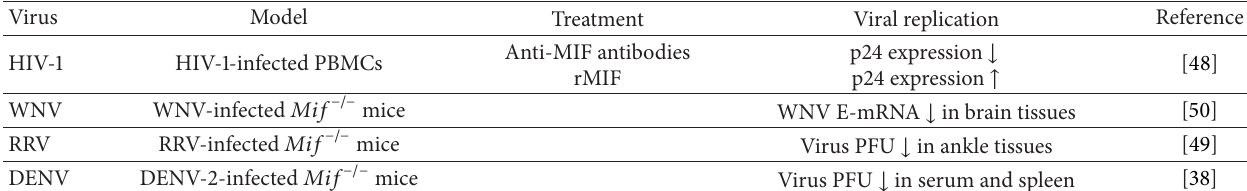
Table 1: Effects of MIF in the replication of different